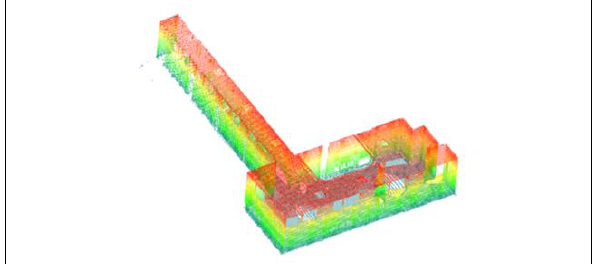
Figure 10. Point cloud of an interior space obtained by terrestrial laser scanning.